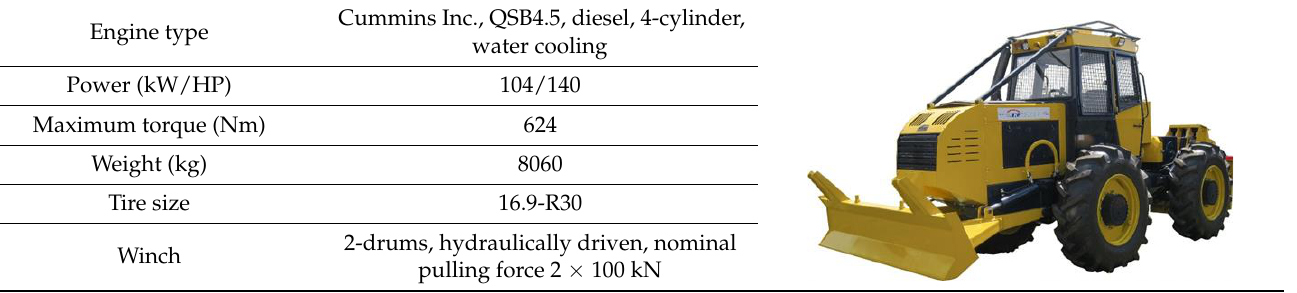
Table 1. Technical characteristics of skidder Ecotrac 140 V.